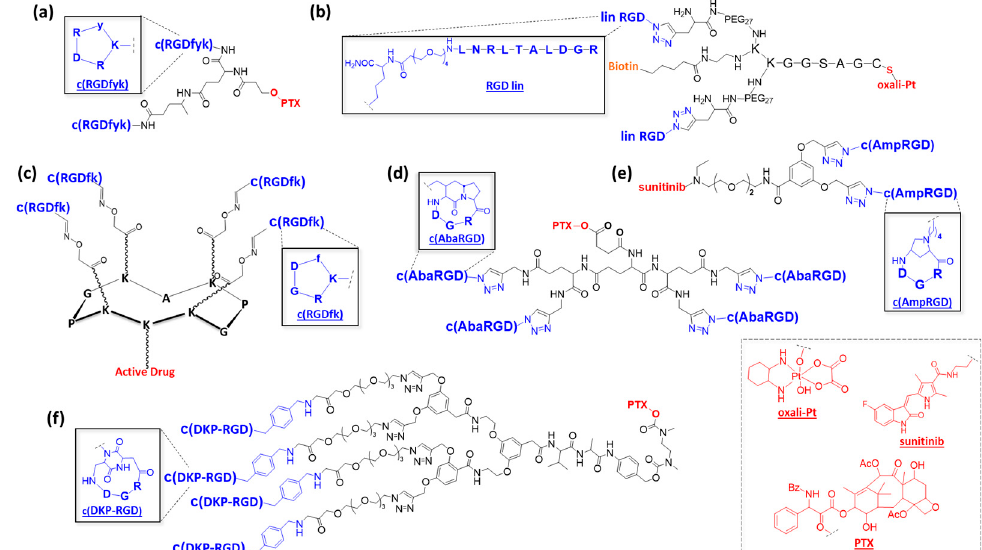
Figure 2. Structures of multimeric RGD compounds: ( a ) c(RGD)–paclitaxel compound [29]; ( b ) c(RGD) Y-shaped peptide core [30]; ( c ) tetrameric c(RGD)-containing cyclodecapeptide [31]; ( d ) c(AbaRGD)–glutamic acid dendrons [36]; ( e ) c(AmpRGD)–triazole, –ether, –amide linkages [38]; ( f ) c(DKP-RGD)–paclitaxel platforms [39].